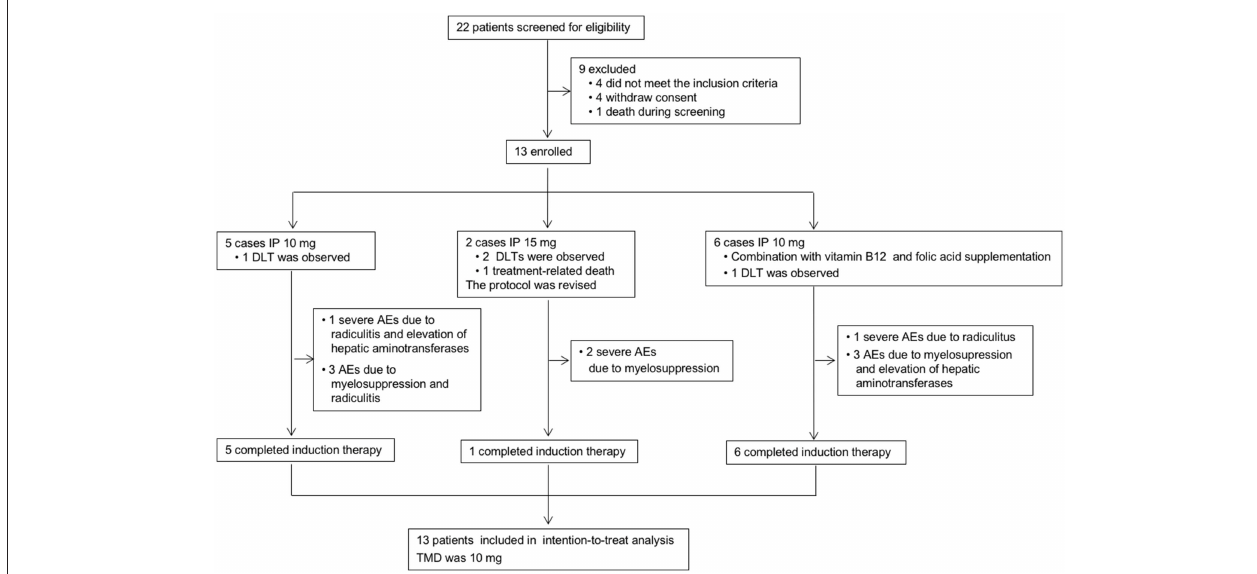
FIGURE 2 | Study profile. IP, intrathecal pemetrexed; DLT, dose-limiting toxicity; AEs, adverse events; MTD, maximally tolerated dose.